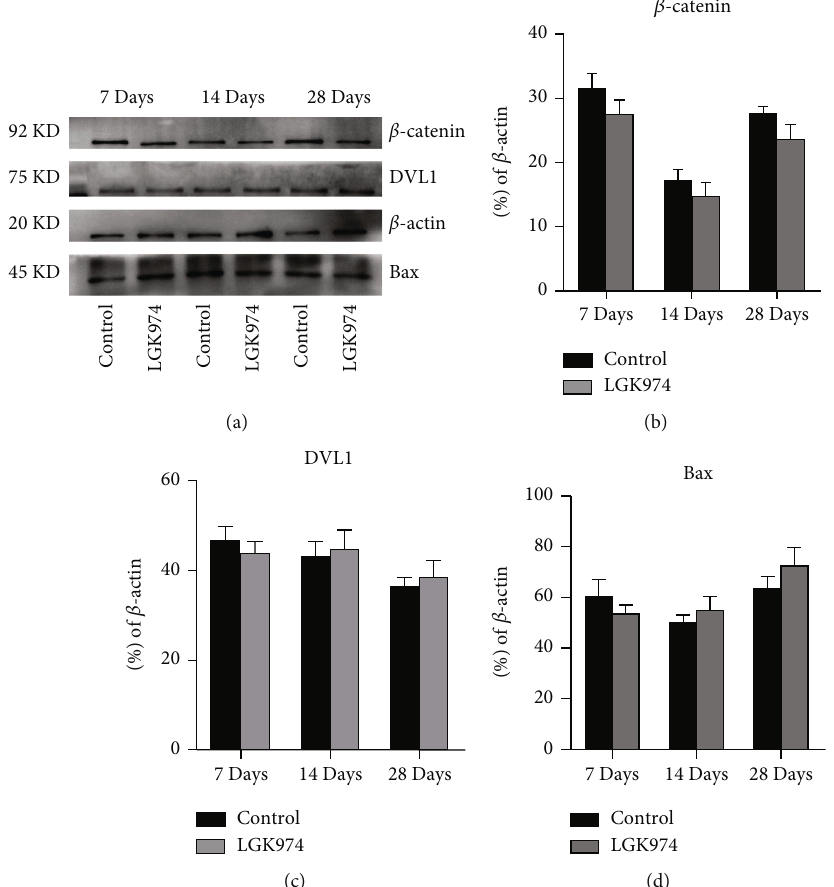
Figure 9: E ff ects of Wnt signaling pathway inhibition (LGK974) on nerve repairing. (a) The expression of β -catenin, DVL1, and Bax was not signi fi cantly increased or decreased. (b – d) Quanti fi cation of western blot bands of DVL1 and β -catenin was summarized. Data were expressed as the mean ± SEM . All samples were taken from the sciatic nerve.